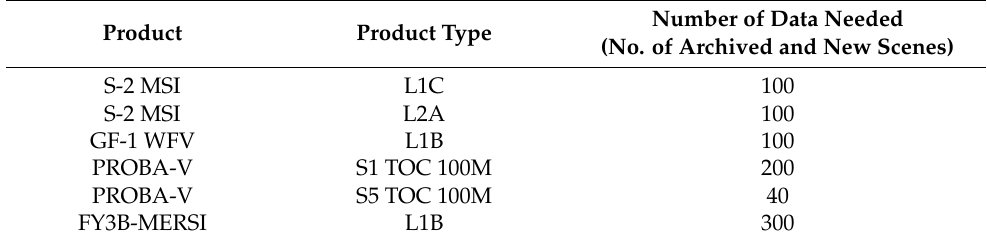
Table 3. List of European and Chinese EO satellite data used in the project.